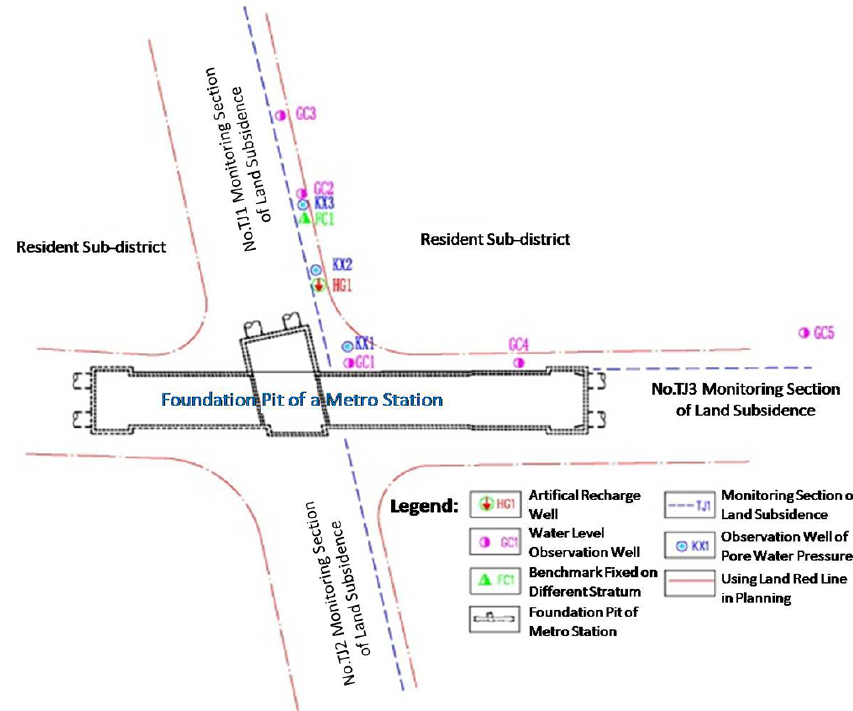
Figure 1. Layout chart of comprehensive testing site of land subsidence control in certain metro station foundation pit.